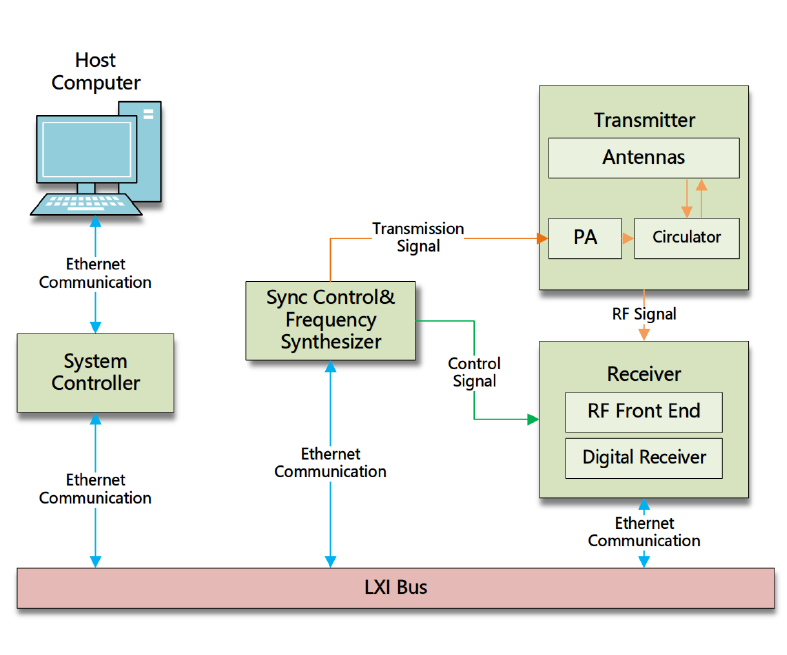
Figure 2. MORSE system